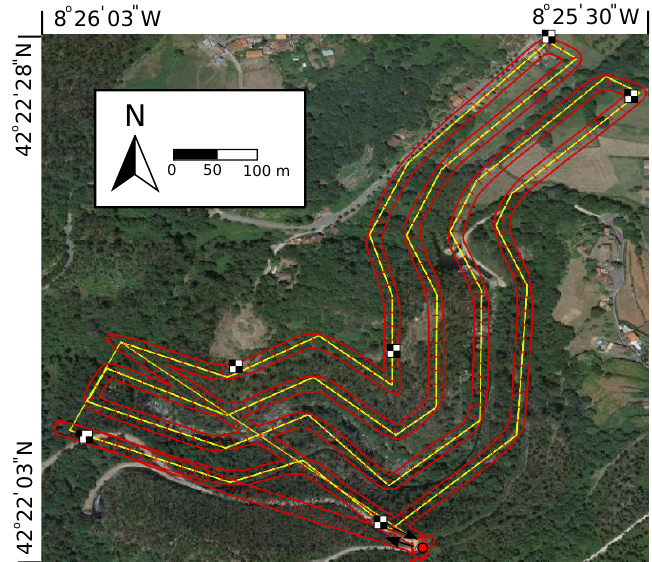
Figure 13. Fight plan for the Oitaven river. The path followed by the UAV is shown with a solid red line and the position of the frames captured by the UAV with red markers. The control points were placed roughly at the corners of the planned route before the flight.